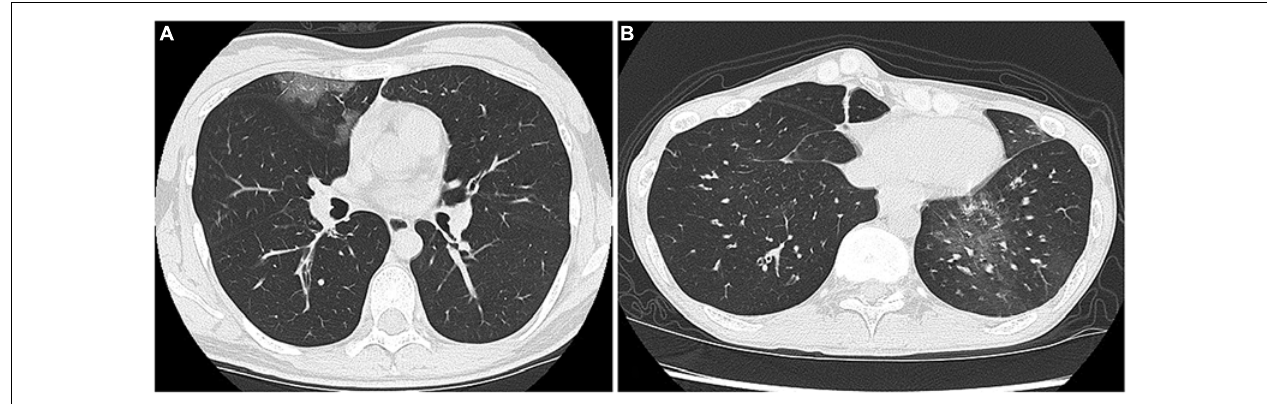
FIGURE 2 | (A) Shows a patchy GGO with thickening of interlobular septa in a 28-year-old woman who was admitted during an asthma attack induced by HRV-A. (B) Also shows GGO in a 62-year-old man with an asthma attack caused by HRV-C infection.